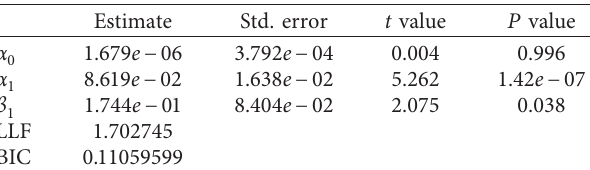
Table 3: Estimated coefficients of the GARCH(1,1) model for the exchange rate.